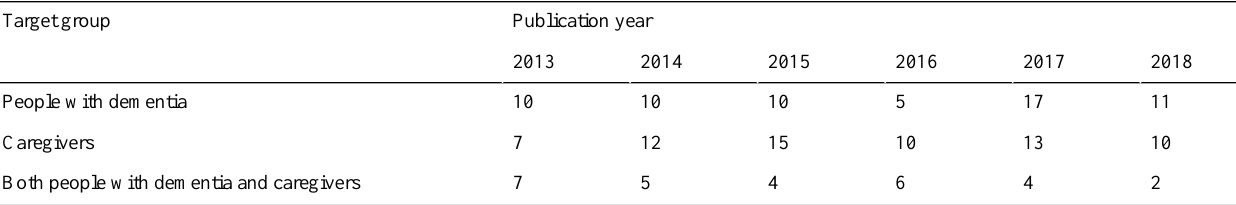
Table 1. Absolute number of publications by publication year